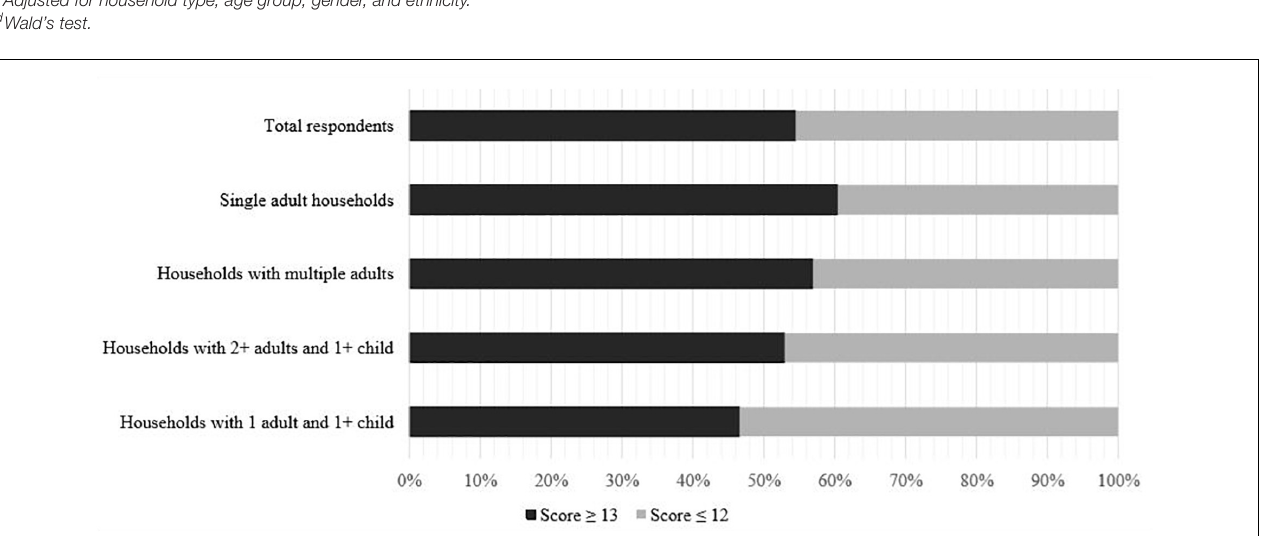
FIGURE 1 | Respondents experience of psychological distress during lockdown.